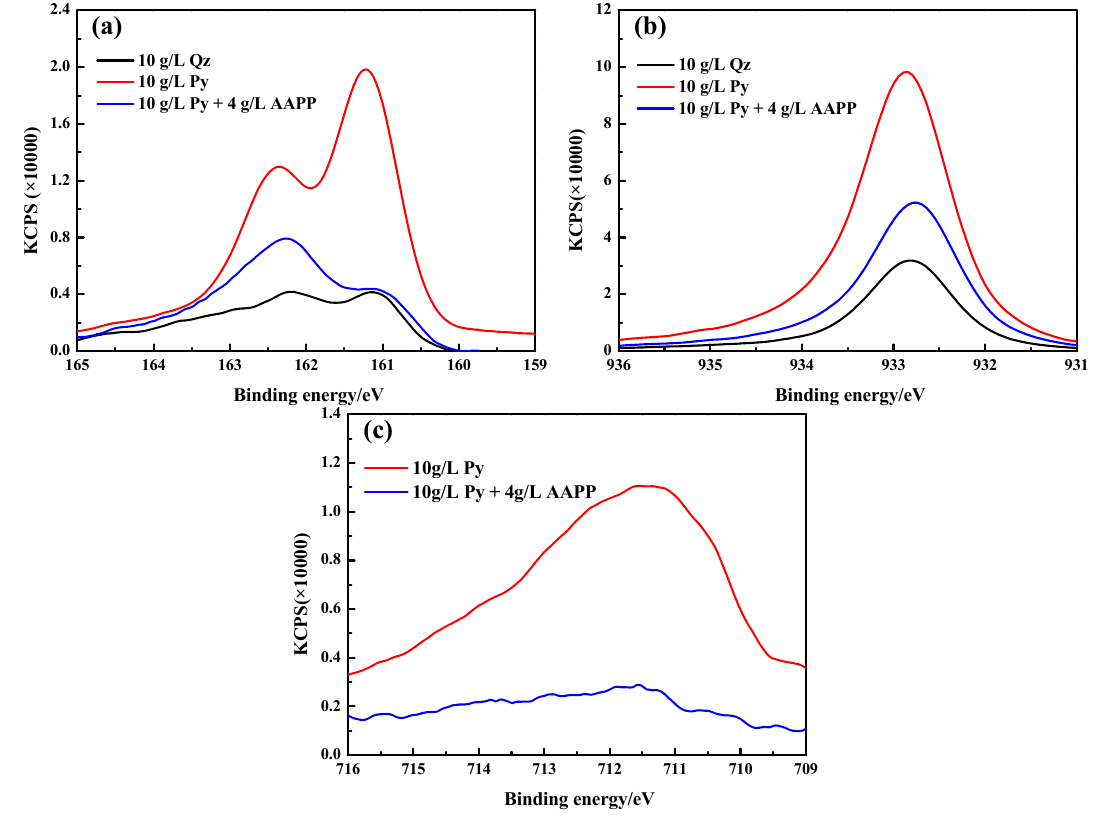
Figure 7. X-ray photoelectron spectroscopy (XPS) spectra of ( a ) S 2p, ( b ) Cu 2p and ( c ) Fe 2p for leached gold foil surfaces in the presence of 10 g/L quartz, 10 g/L pyrite and 10 g/L pyrite with the addition of 4 g/L AAPP.